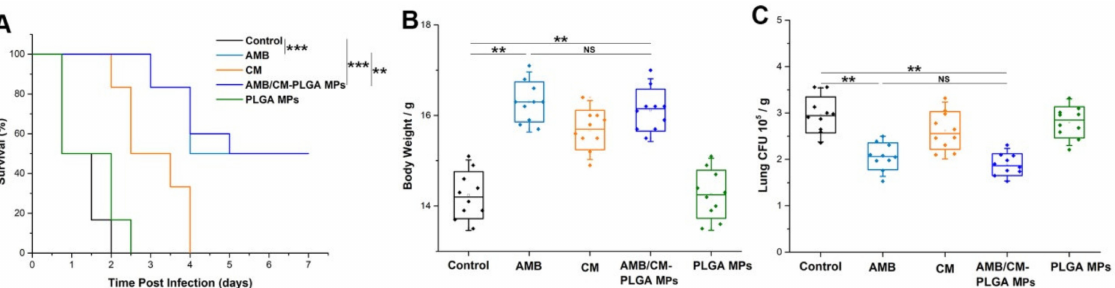
Figure 7. In vivo antifungal activity test. ( A ) Survival curves were monitored in the following 7 days upon C. albicans infection. ( B ) Body weight was measured 24 h post-infection. ( C ) Lung tissue fungal burdens were tested using CFU assay. The final concentration of AMB employed in the AMB group and the AMB/CM-PLGA MPs group was 0.5 µ g/mL; the final concentrations of CM and PLGA MPs were 1.2 and 1.7 µ g/mL, respectively, which were the same as those contained in the AMB/CM-PLGA MPs group. ** p < 0.05. *** p < 0.01. NS means no